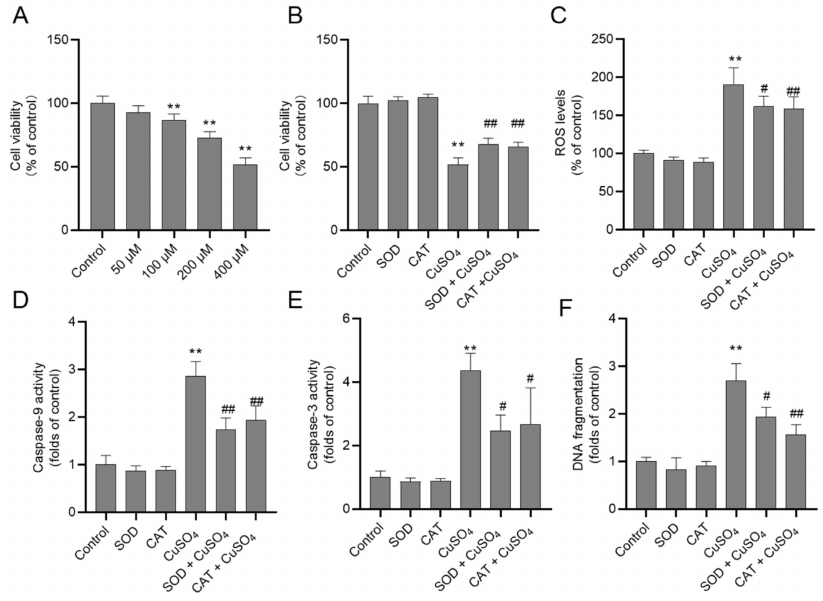
Figure 5. Changes of the cell viability, reactive oxygen species (ROS) production and the activities of caspase in HEK293 cells. ( A ) CuSO 4 exposure at the dose of 50–400 µ M induces the decreases of cell viability in a dose-dependent manner. ( B – E ), pre-treatment with superoxide dismutase (SOD), and catalase (CAT) inhibit CuSO 4 exposure-induced decreases of cell viability ( B ), the production of ROS ( C ), the up-regulation of caspase-9 ( D ) and -3 ( E ) activities and increases of DNA fragmentation ( F ). Values were from three independent experiments and presented as mean ± SD ( n = 3). ** p < 0.01, compared to the control group. # p < 0.05, or ## p < 0.01, compared to the CuSO 4 alone treatment group.